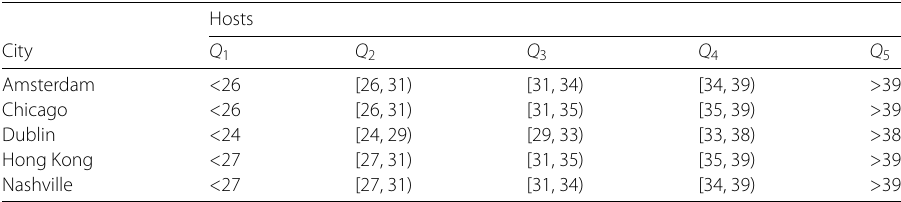
Table 4 Quintiles of Airbnb’s host age distributions for full property rentals. Q 1 denotes the bottom 20% of the age distribution, Q 2 denotes users falling between the bottom 20% and 40% of the age distribution, and so